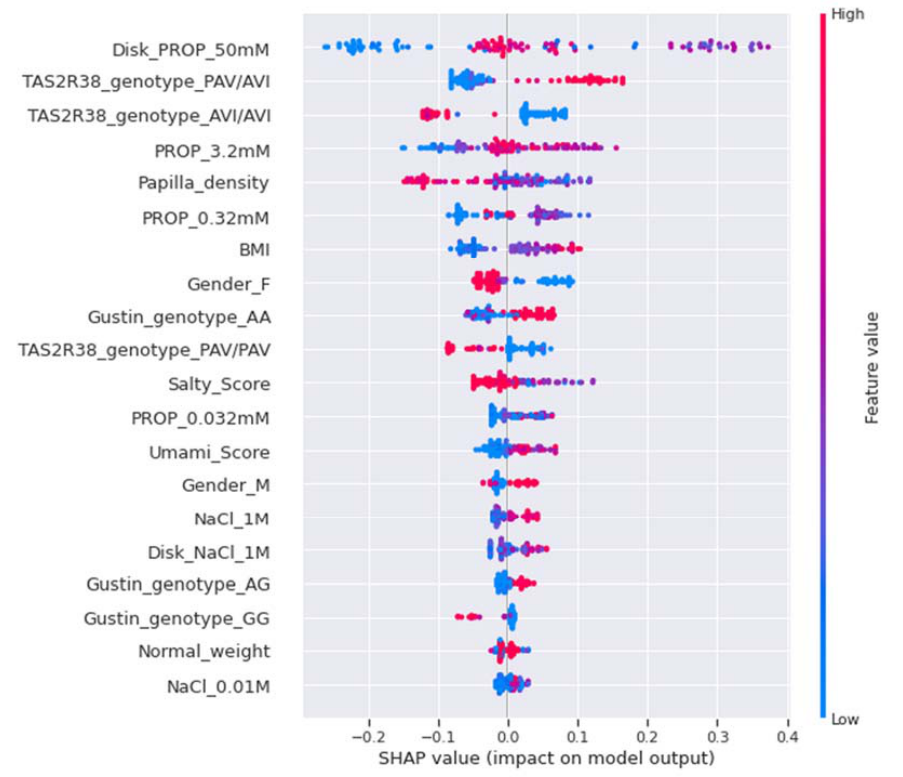
Figure 7. SHAP summary plot of the MT category. The left ‐ hand side of the Y ‐ axis represents the descending order of importance of the MT category features; the X ‐ axis represents the impact of the SHAP value on the output model. The color represents the feature value: high values have a pink color, while low values have a blue one.